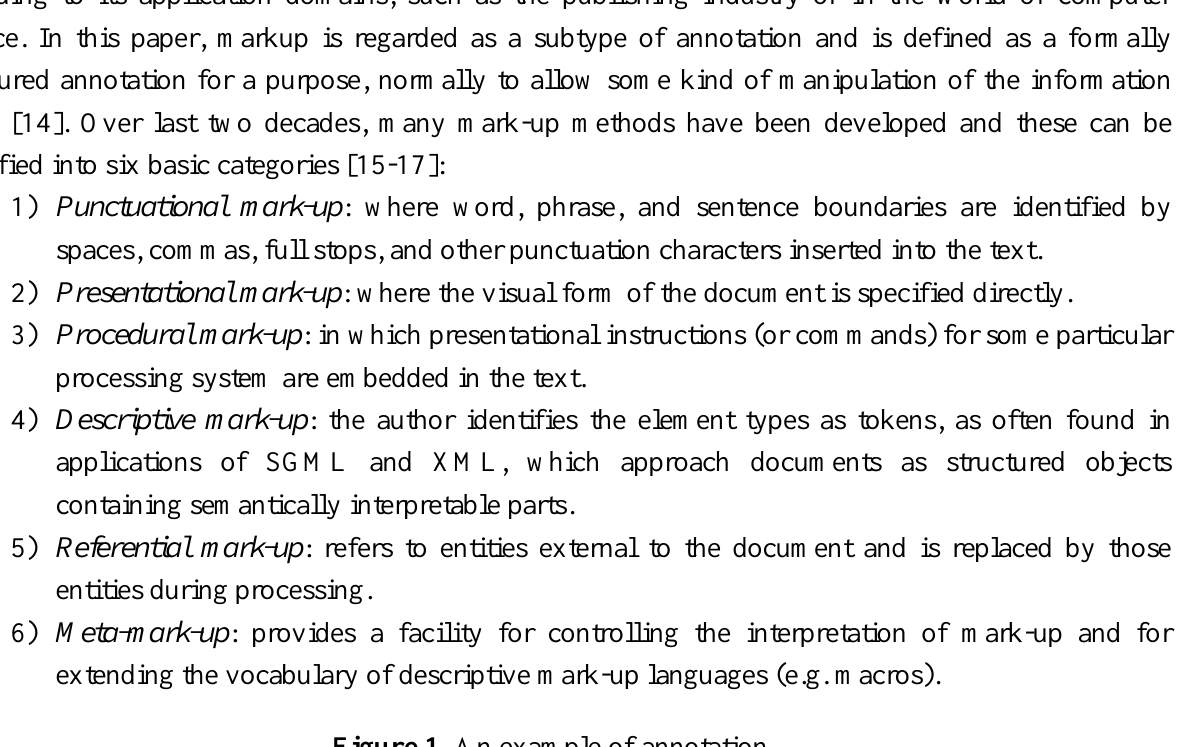
Figure 1. An example of